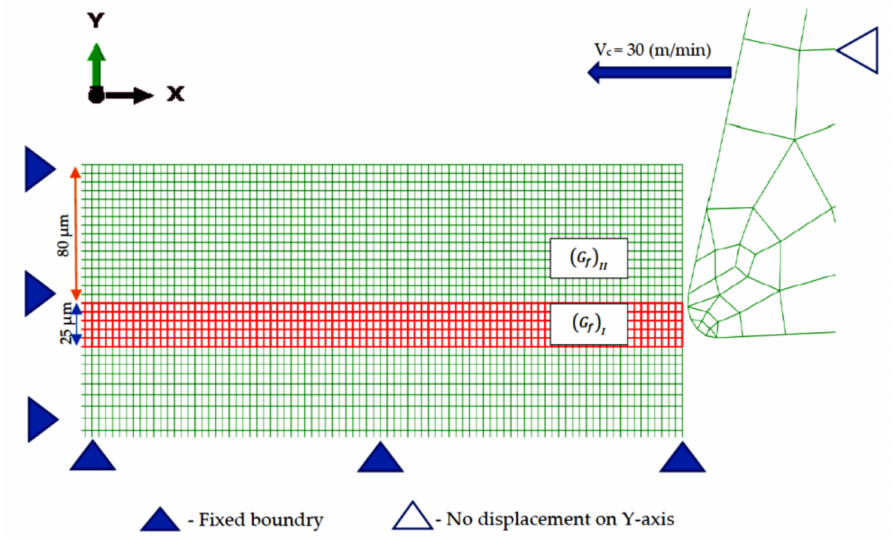
Figure 5. Finite element model for the uncut chip thickness of h = 100 µ m with relevant information’s on geometry, mesh, boundary condition and fracture energy